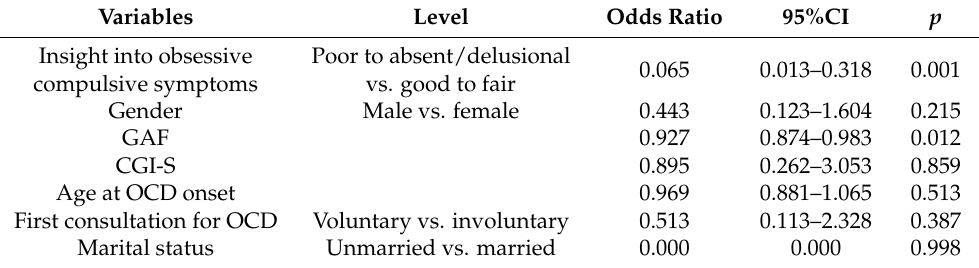
Table 3. Multivariate logistic regression analysis of factors of OCD with psychotic disorder ( n = 28) and OCD without psychotic disorder ( n = 58): sociodemographic profiles, clinical features, and